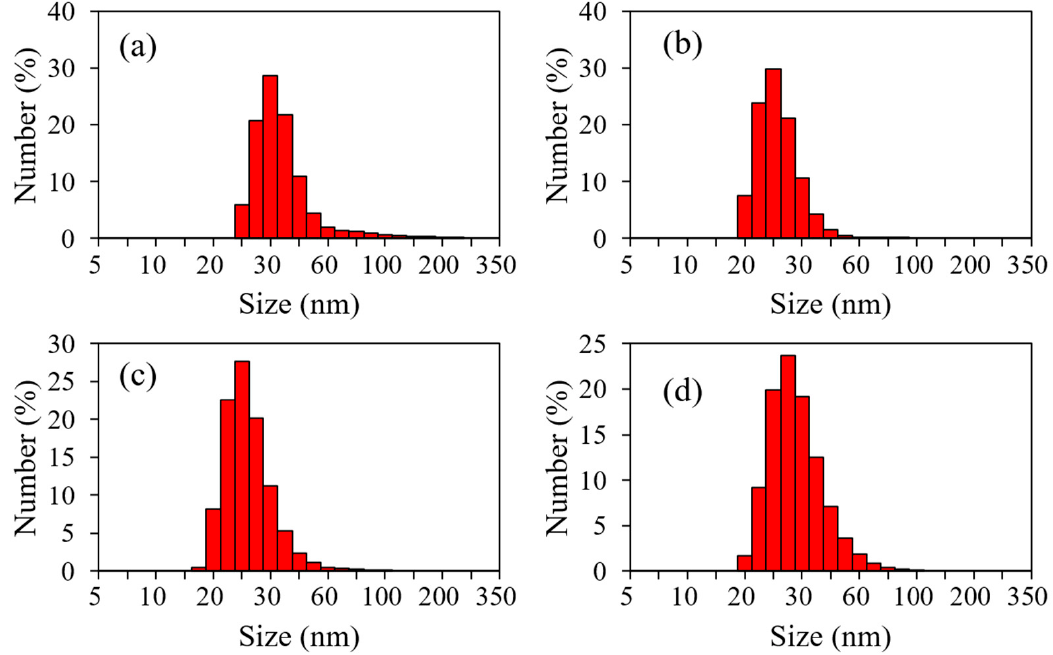
Figure 7. Number size distributions of the ZrO 2 nanoparticles in the toluene dispersions synthesized at ( a ) 250 °C, ( b ) 300 °C, ( c ) 350 °C, and ( d ) 400 °C obtained using dynamic light scattering.